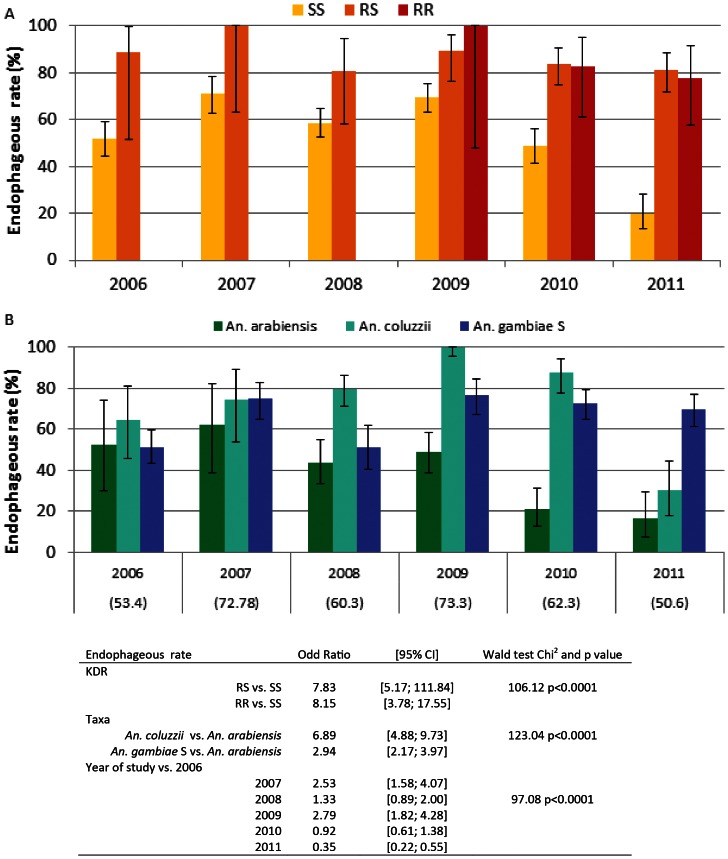
Endophageous rate (% and 95% confidence interval) measured in 1494 An. gambiae s.l. mosquitoes sampled from 2006 to 2011, according to their kdr genotype (SS: wilde type yellow box, RS: L1014 F heterozygote orange box, RR: L1014F homozygote red box, Panel A) and taxa (An. arabiensis, green boxes, An. coluzzii, light blue boxes, and An. gambiae molecular form S, darck blue boxes, Panel B).Rates in the total Anopheles gambiae s.l. population are given in brakets. Data in the table represent Odd ratio (OR) obtained with a logistic model of parity with following factors: KDR genotype, taxa and year. Likehood ratio Chi2 = 330.68, p<0.001.